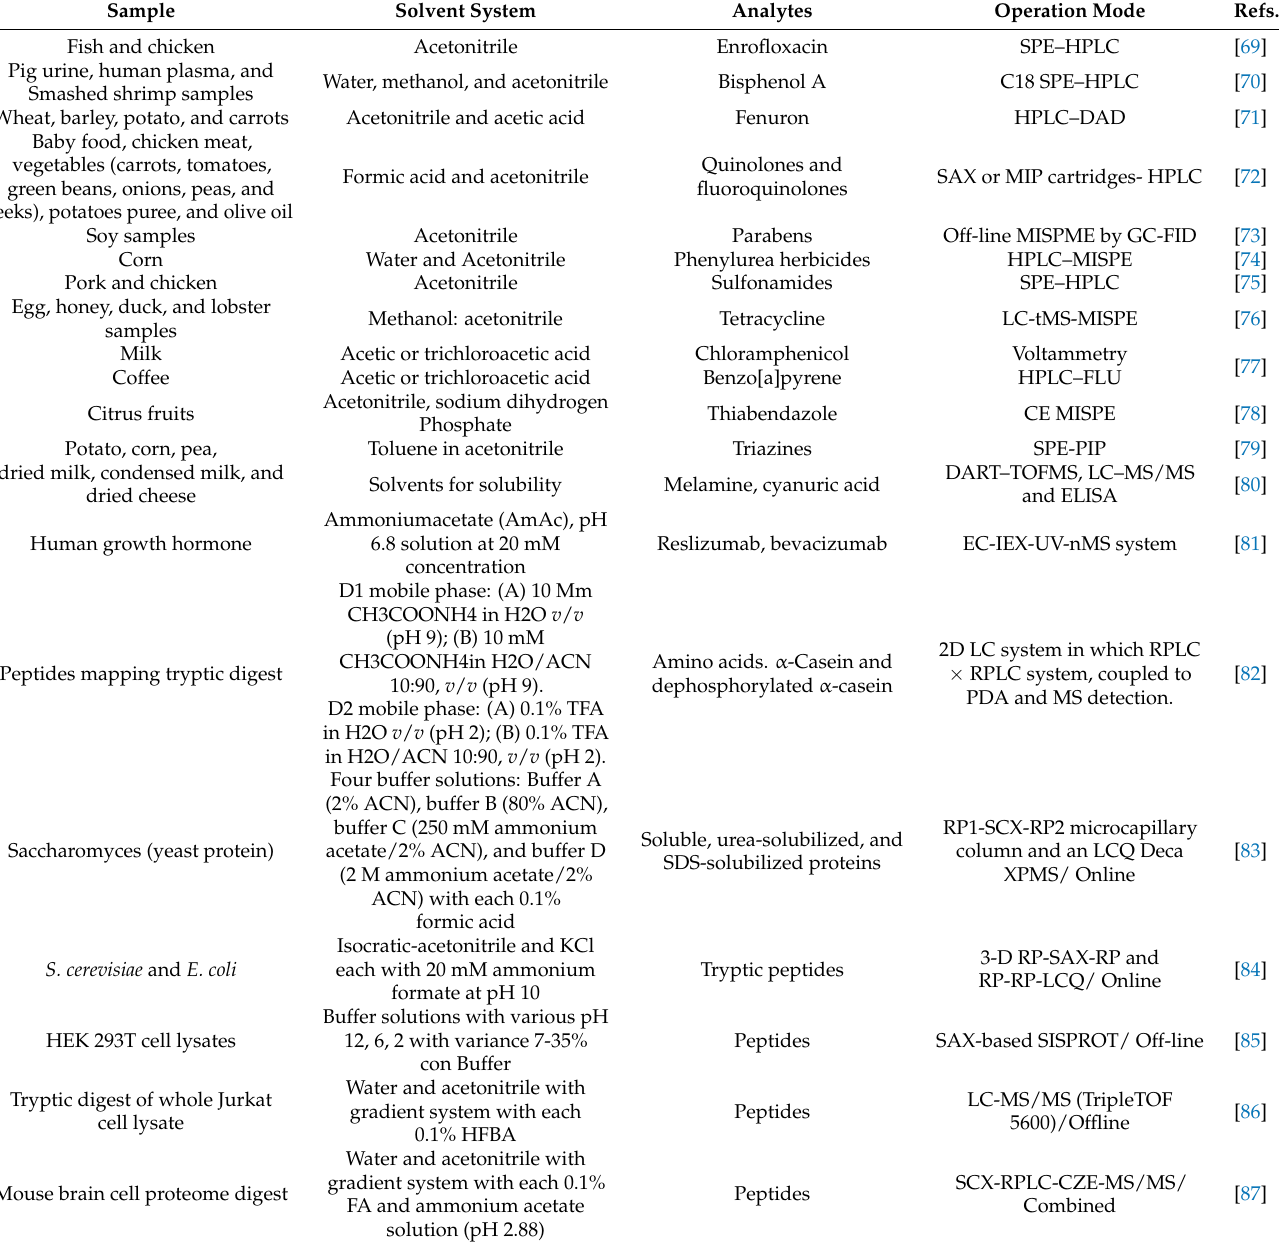
Table 1. Utilization of multidimensional chromatography in food products, biological samples, industrial, environmental, and